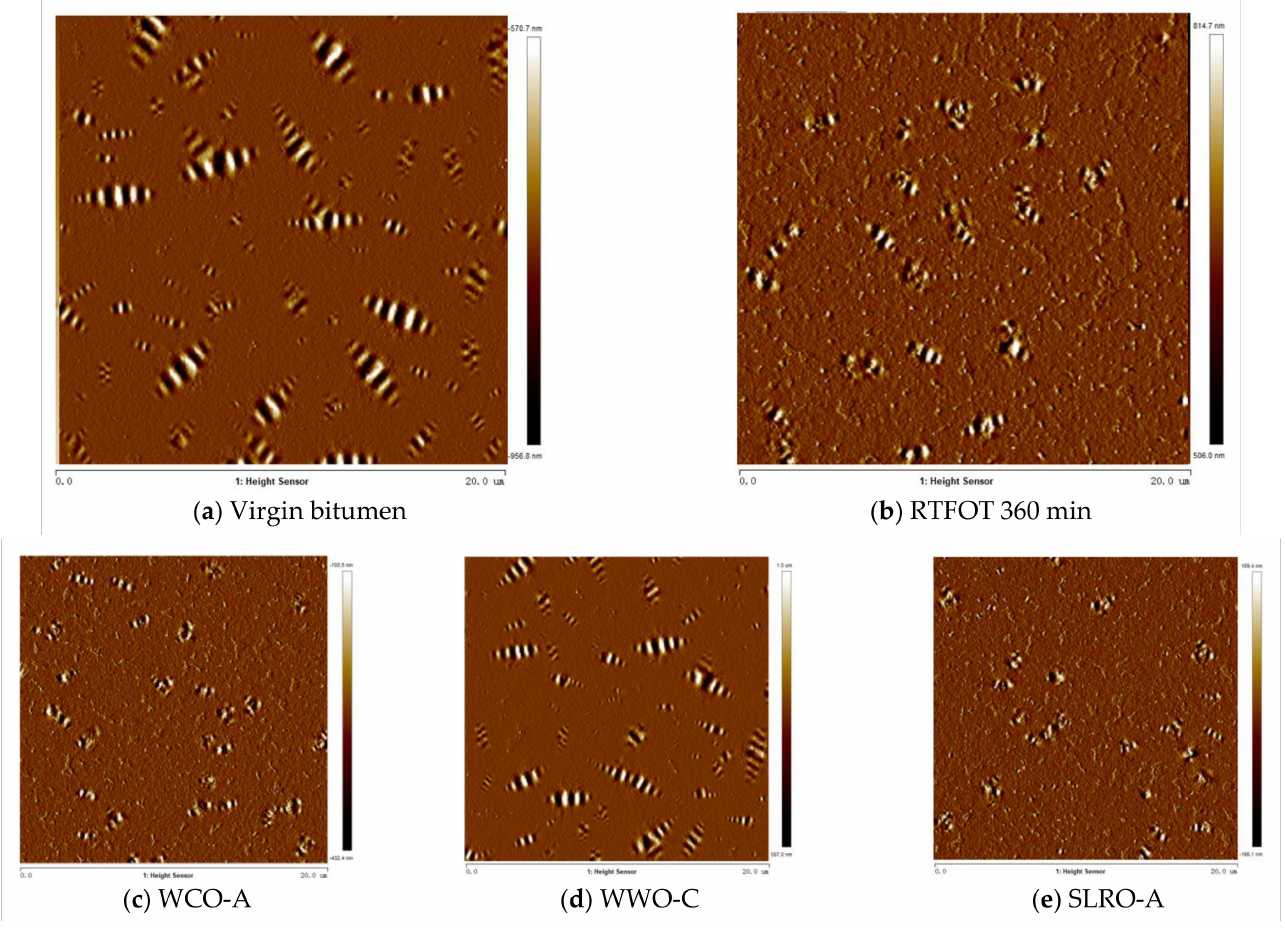
Figure 19. Effect of bio-oil on micromorphology of